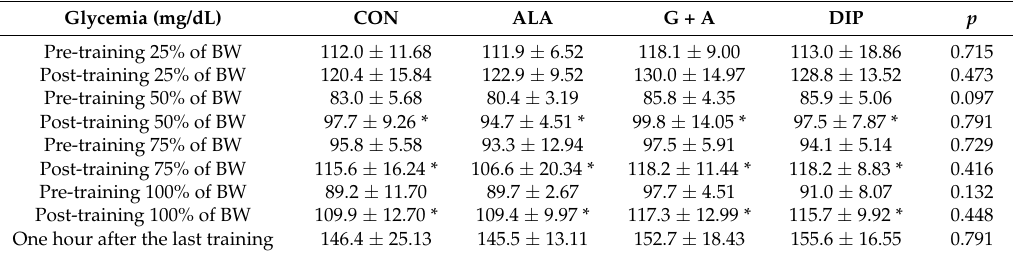
Table 3. Glycemia before and after training.